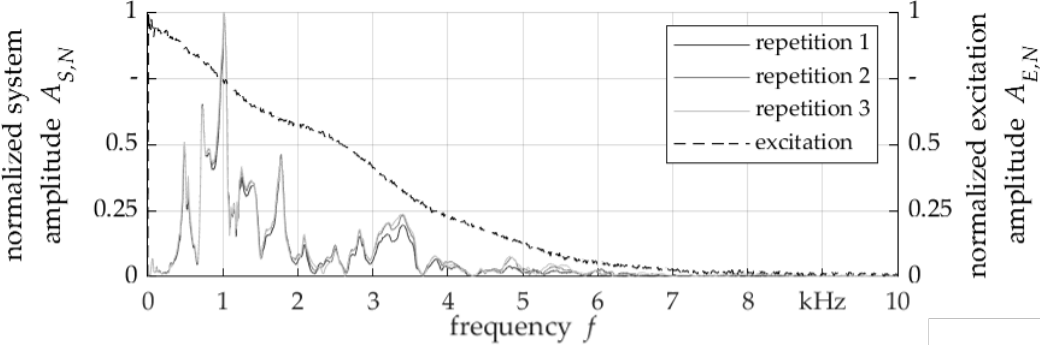
Figure 6. System response of the setup based on the excitation with an impact hammer.